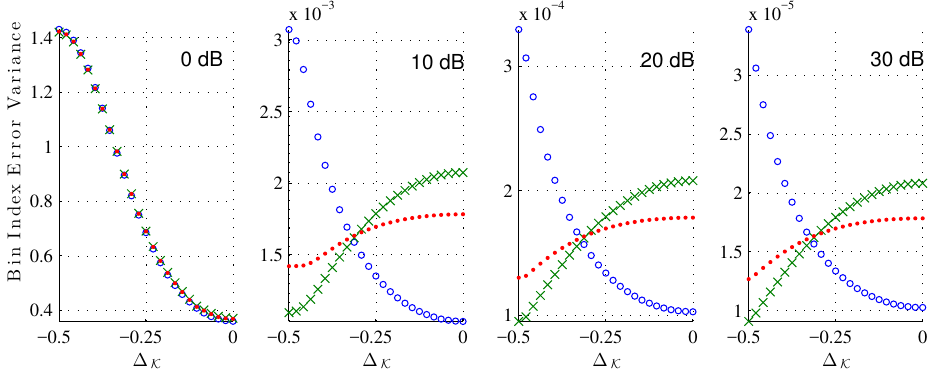
◦ × ), the LQIFFT ( ), and the XQIFFT (